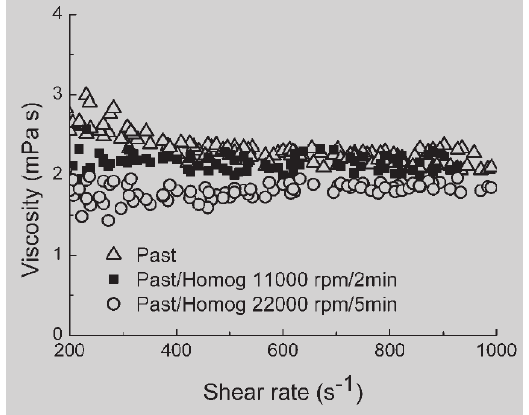
Table 2 (above): Viscosity (mPa·s), soluble and insoluble solid content (g 100mL -1 ), and particle diameter ( m m) for crude, enzymatically treated, and pasteurized pulp.